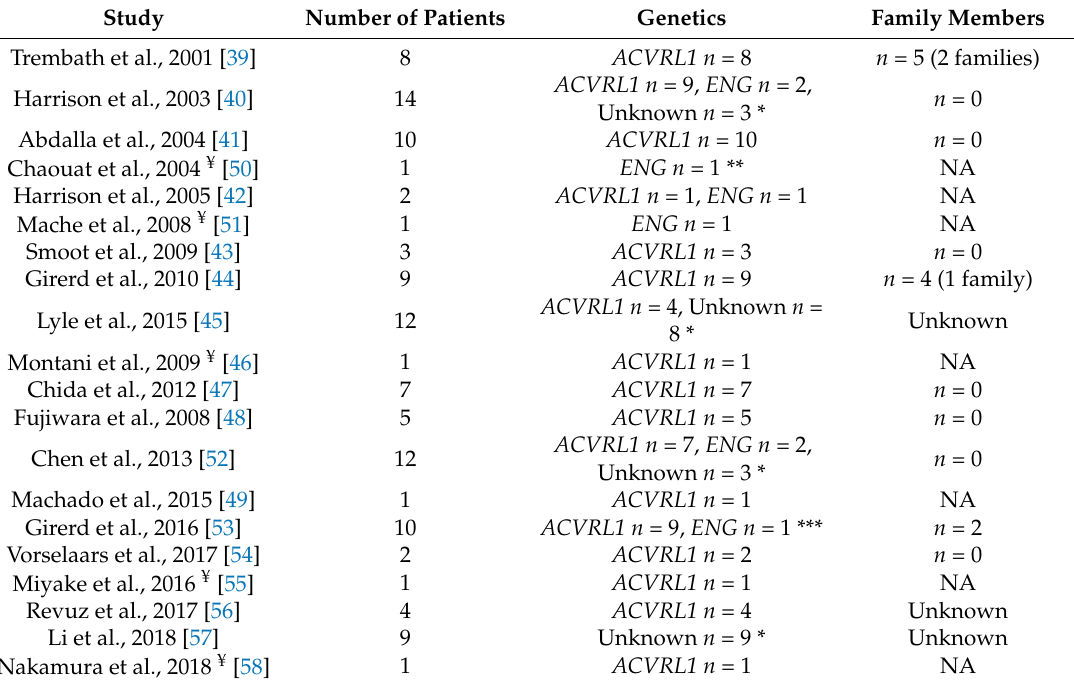
Table 1. PAH-HHT patients described in